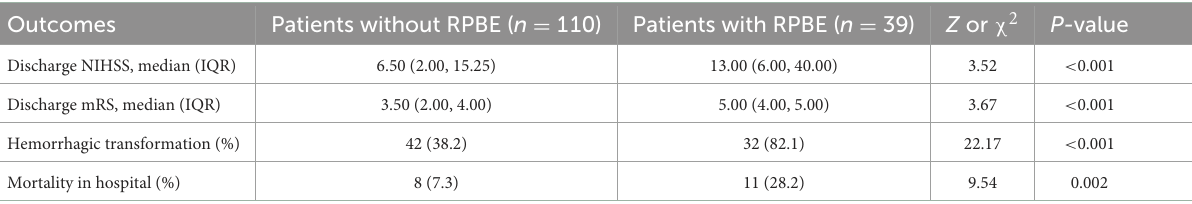
TABLE 2 The effect of RPBE on poor outcomes in